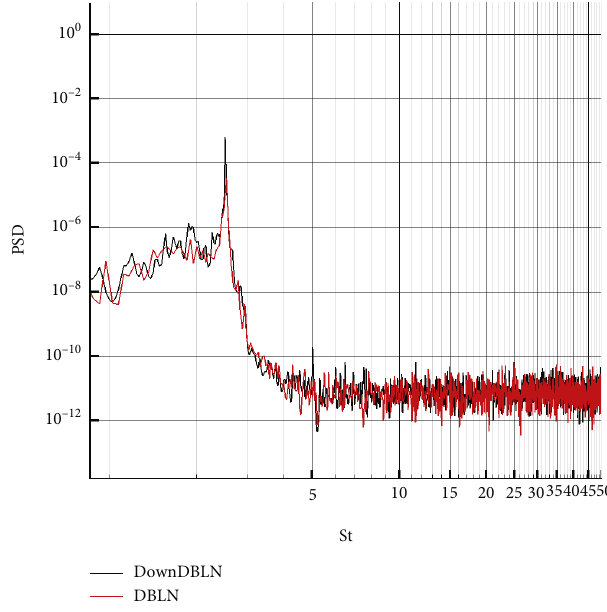
Figure 22: PSD of DownDBLN and DBLN-526 ( Re = 0 : 8 E 6 , α = 0 °